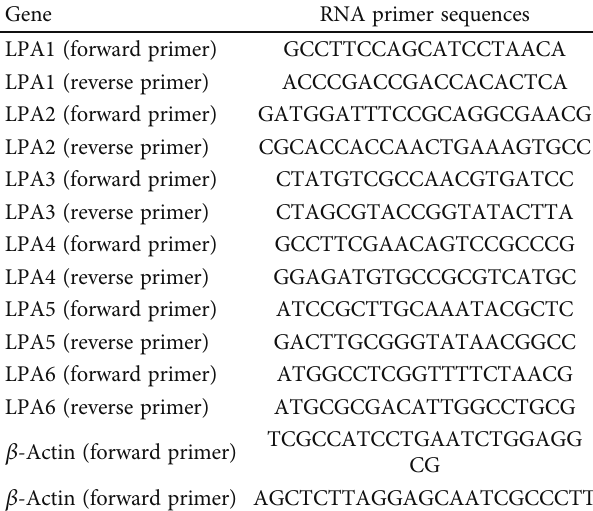
Table 3: LPA and LPC levels in CSF between the severe and mild groups with NPSI in the